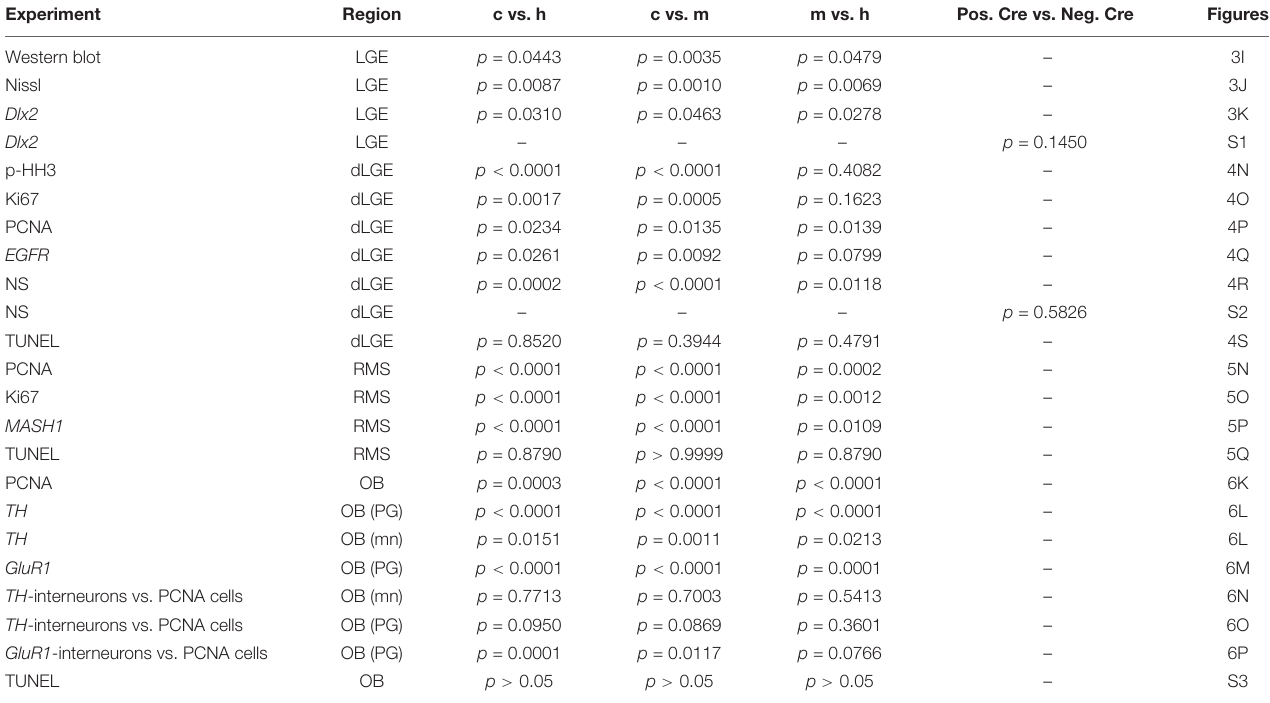
TABLE 2 | Summary of p -values from the post hoc test or Student’s t -test.